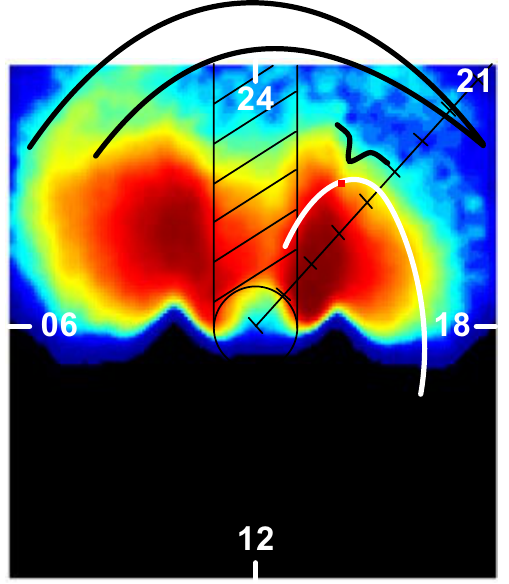
Fig. 6. EUV image at 04:32 UT on 11 April 2002. The image has been smoothed by a spatial low frequency filter. Contrast has been enhanced by means of a nonlinear color scaling based on histogram equalization. The black circle corresponds to the approximate size and position of the Earth, with its shadow extending towards the op- posite direction to the Sun. The plume is delimited by the black line and one density irregularity is indicated by the small black indenta- tion. The white curve is the trajectory of the four Cluster satellites between 3h before and 3h after the time of this EUV image, and the red dot corresponds to the position of the Cluster spacecraft at 04:32 UT.